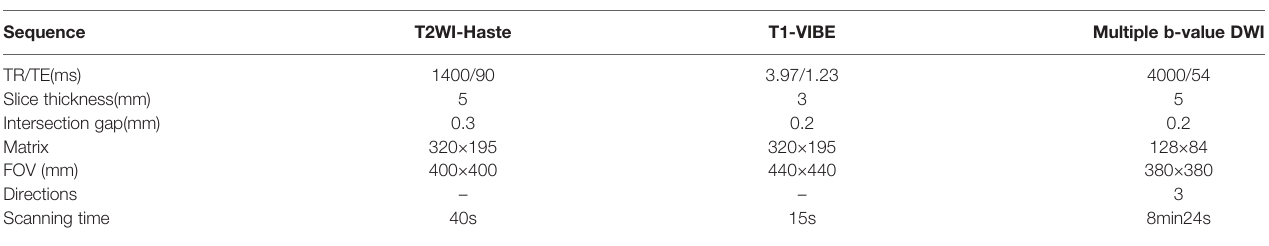
TABLE 1 | Scanning parameters of MRI.